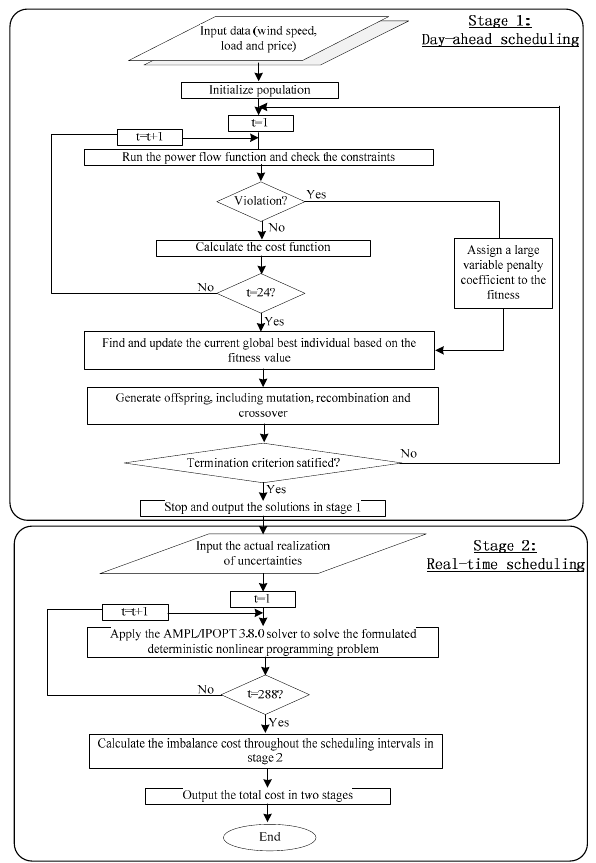
Figure 2. Flow chart of the applied solution